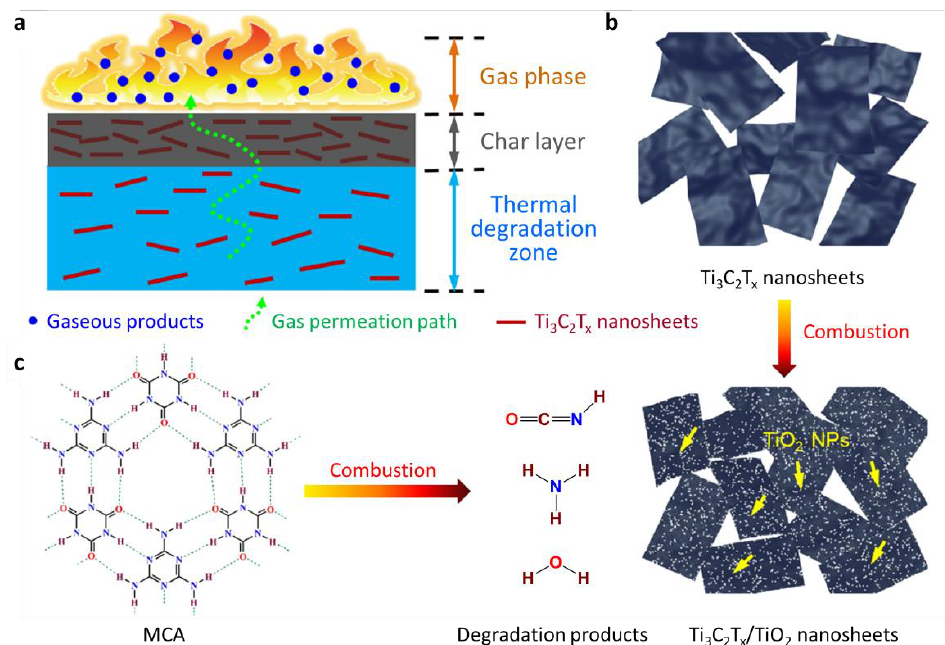
Figure 39. ( a ) Illustration of flame-retardant model of TPU/Ti 3 C 2 T x @MCA nanocomposites; ( b ) combustion conversion of Ti 3 C 2 T x nanosheets (TiO 2 NPs: TiO 2 nanoparticles); and ( c ) degradation of MCA upon combustion. Reprinted with permission from Ref. [249]. Copyright 2020, Elsevier.